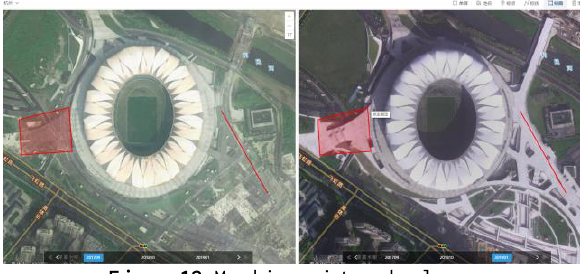
Figure 12. Marking points and